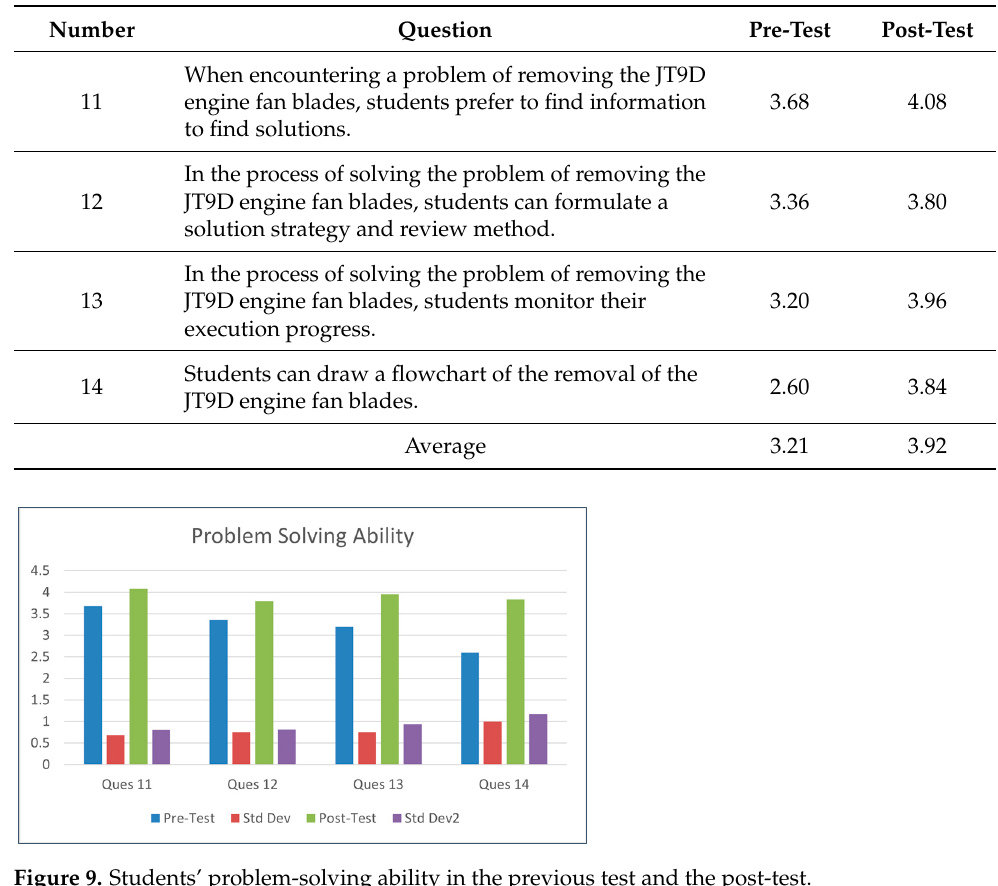
Table 6. The results for problem-solving ability.